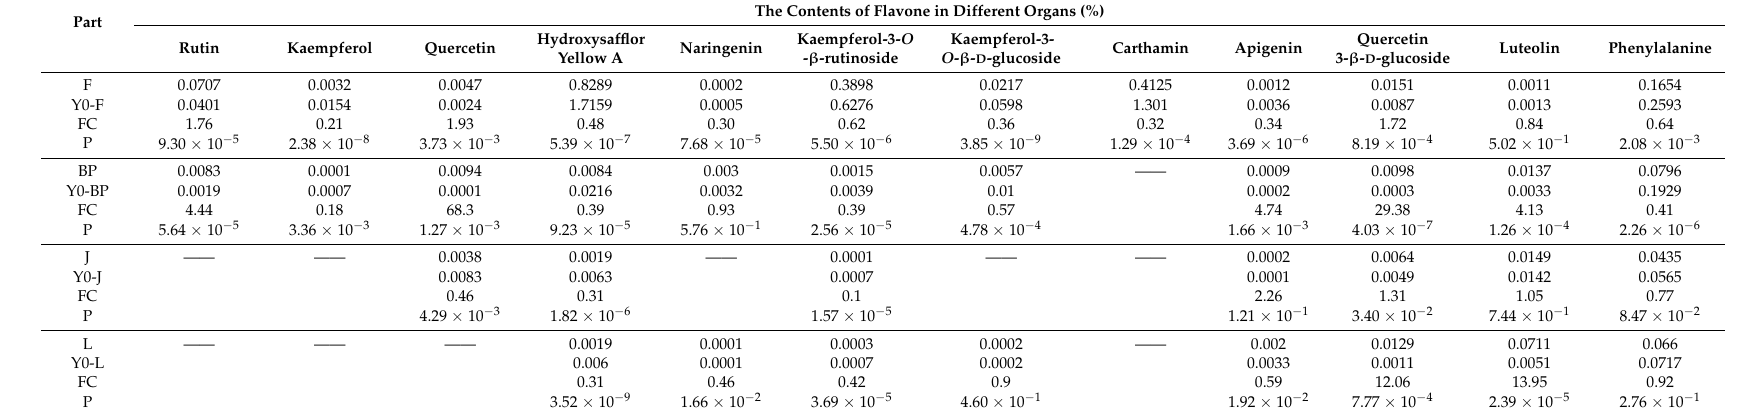
Table 3. The quantitative determination results of 12 metabolites from 4 different parts of